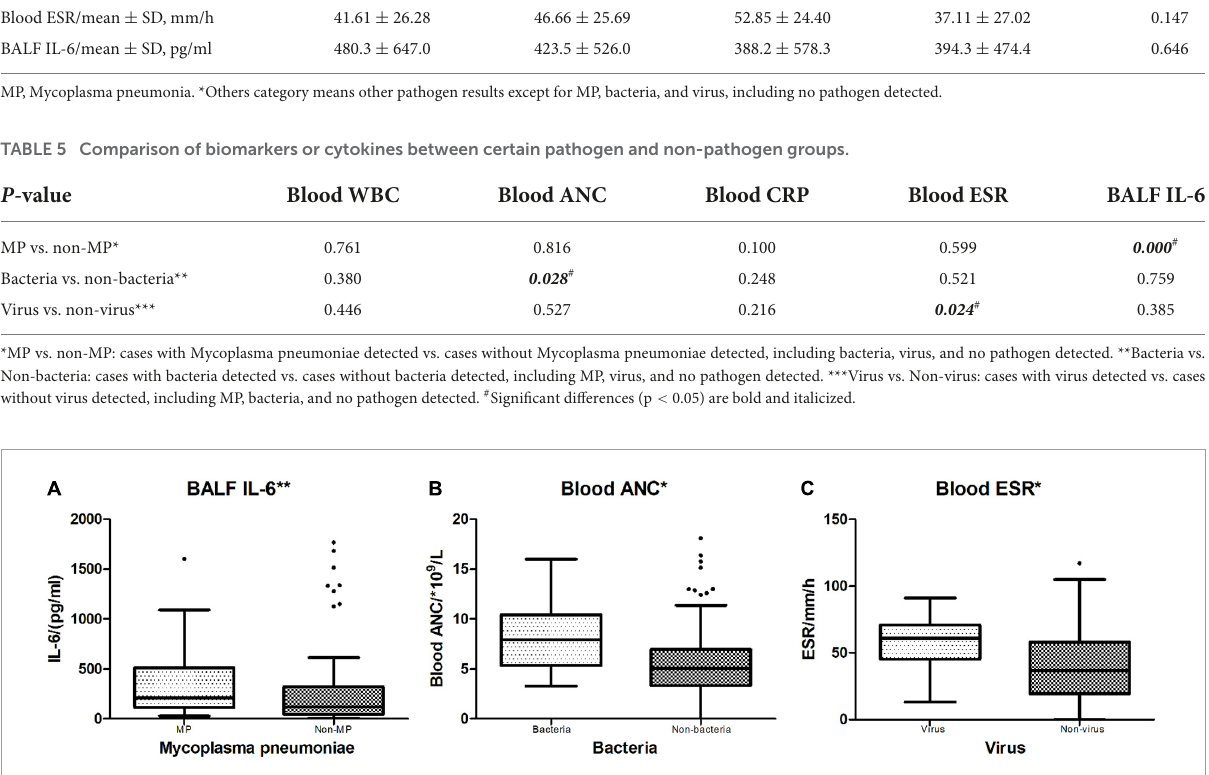
FIGURE4 Indicators between different positive vs. non-positive pathogen groups. * p < 0.05; ** p < 0.01. (A) MP vs. non-MP: Mycoplasma pneumoniae-detected cases vs. no Mycoplasma pneumoniae-detected cases. BALF IL-6 showed a significant difference between MP and non-MP groups ( p = 0.000). (B) Bacteria vs. Non-bacteria: Bacteria-detected cases vs. no bacteria-detected cases. Blood ANC had a significant difference between Bacteria and Non-bacteria groups ( p = 0.028). (C) Virus vs. non-virus: Virus-detected cases vs. no virus-detected cases. Blood ESR had a significant difference between Virus and Non-virus groups ( p =